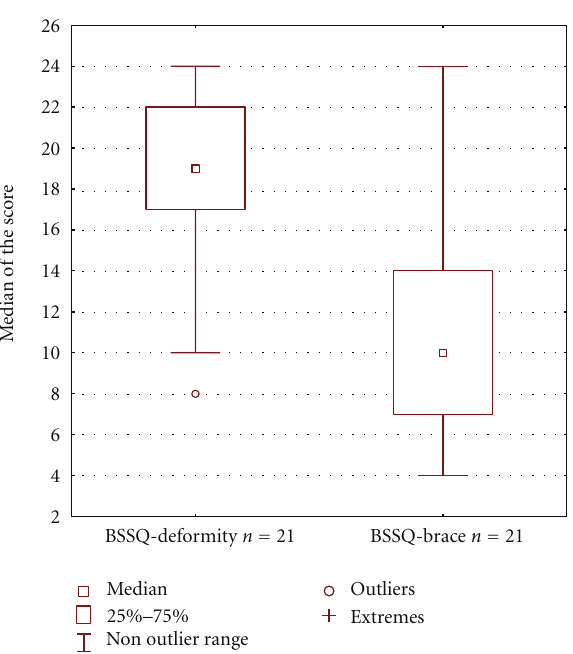
Figure 1: The scores of two questionnaires: the BSSQ-Deformity and the BSSQ-Brace applied to the same subgroup of patients treated with both brace and physiotherapy ( n =